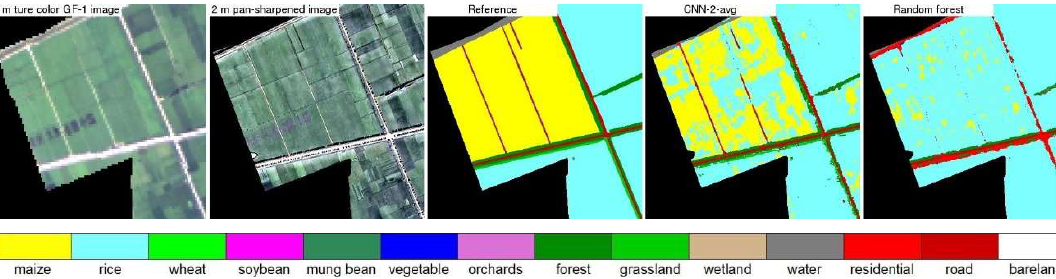
Figure 10. Same as Figure 7 but for the example 400 × 400 pixels in the box area in study area 4 (Figure 3). 4.4. CNN and Random Forest Accuracy Comparison for Balanced Training Data All the previous results were derived from the training samples which are proportional to the land cover occurrence in the reference land cover maps. To examine the training sample balance effect, in this section, the CNN and random forest were trained using the sample data balanced among different classes, i.e., same number of training samples for all the classes. Table 6 lists the balanced testing dataset classification accuracies for the four study areas. The random forest is still inferior to the CNN model by 3.8–9.1% overall accuracy and 0.04–0.10 kappa coefficients. However, the overall accuracy of CNN model is only 78–85% that is lower than the imbalanced training dataset (Table 5). This is because overall accuracy may be boosted for imbalanced dataset by simply classifying most pixels as the majority classes. Similarly, the user’s and producer’s accuracies for CNN are more balanced than that for random forest. Table 6. Balanced sample accuracies of the random forest and the CNN2-Avg model for study areas 1–4 samples data. A total of 2000 training and 2000 testing samples were randomly selected from Table 3 (class with samples <4000 was not used). The training sample percent to the total training samples (the value is same for the testing sample) is shown in the bracket after class name. Classes